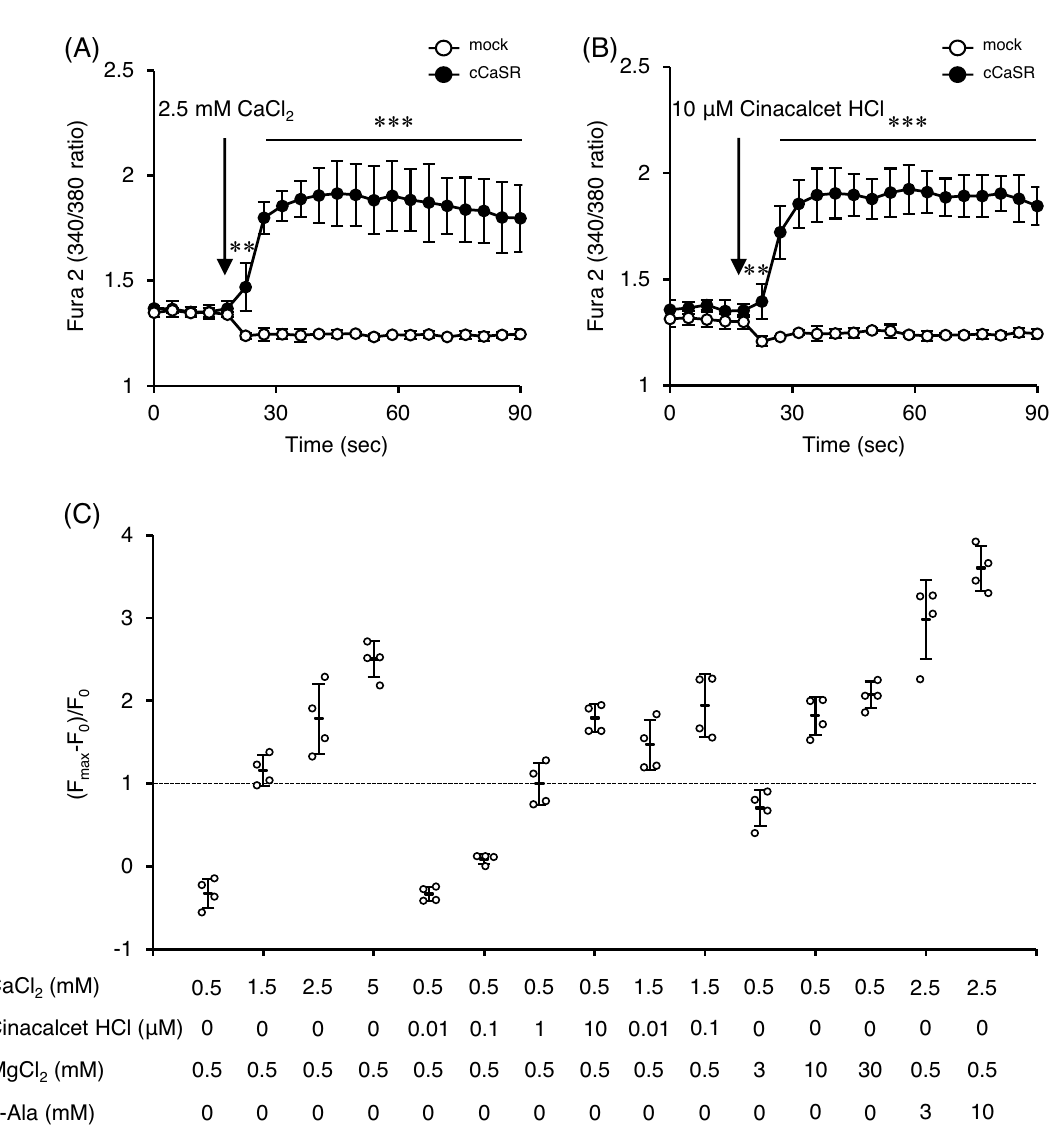
Figure 7. A representative calcimimetic, cinacalcet HCl, activated cCaSR. ( A ) Fura 2 fluorescence ratios in cCaSR-expressing HEK293T cells were increased by 2.5 mM CaCl 2 , but the increase was not observed in mock cells. ( B ) Ten μM cinacalcet HCl activated cCaSR. ( C ) The (F max −F 0 )/F 0 after various stimuli are shown. F 0 means the initial value of Fura 2 fluorescence ratio. F max means the maximum value of Fura 2 fluorescence ratio after stimulus. These values are normalized by the values of 1 μM cinacalcet HCl. Data are means ± SD (n = 4 wells). ** P < 0.01 and *** P < 0.001 by two-way repeated measures ANOVA followed by unpaired t